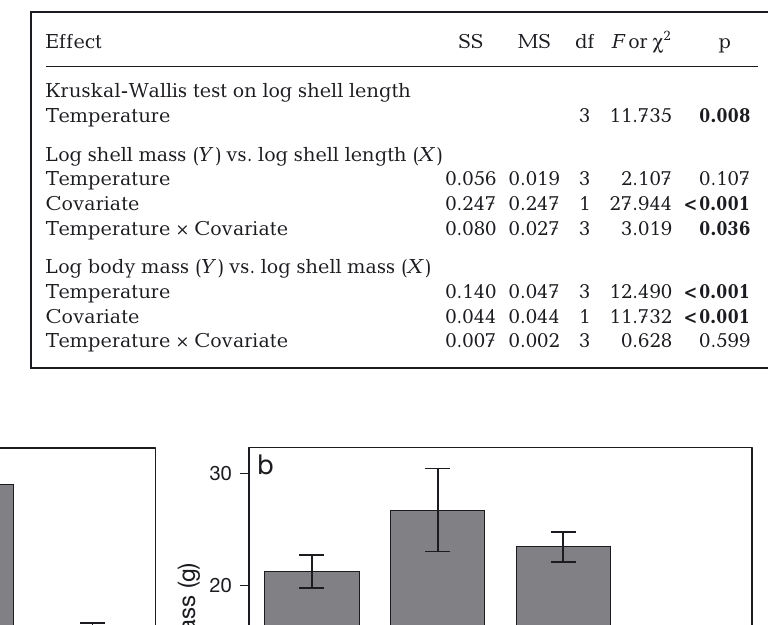
Table 1. Nested ANCOVAs ( F -test) on body mass and shell mass, and Kruskal- Wallis test (rank sum test, χ 2 ) on shell length for Rapana venosa from 4 temp- erature treatments. Significant effects in bold